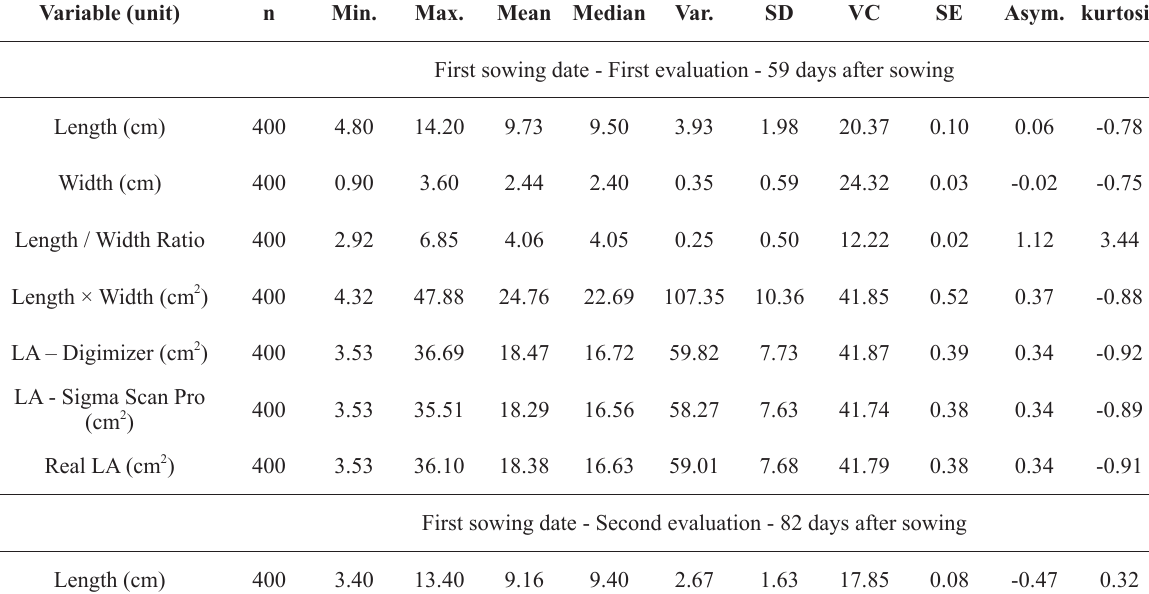
Number of leaves (n), minimum (Min.), maximum (Max.), mean, median, variance (Var.), standard deviation (SD), variation coefficient (VC, %), standard error (SE), asymmetry (Asym.) and kurtosis in 3,200 leaves of Crotalaria juncea - measuring 400 leaves by evaluation in each sowing - used to generate the leaf area (LA) estimation models in function of linear dimensions in the 2014/15 harvest in Itaqui - RS - Brazil. Variable (unit) n Min. Max. Mean Median Var. SD VC SE Asym.